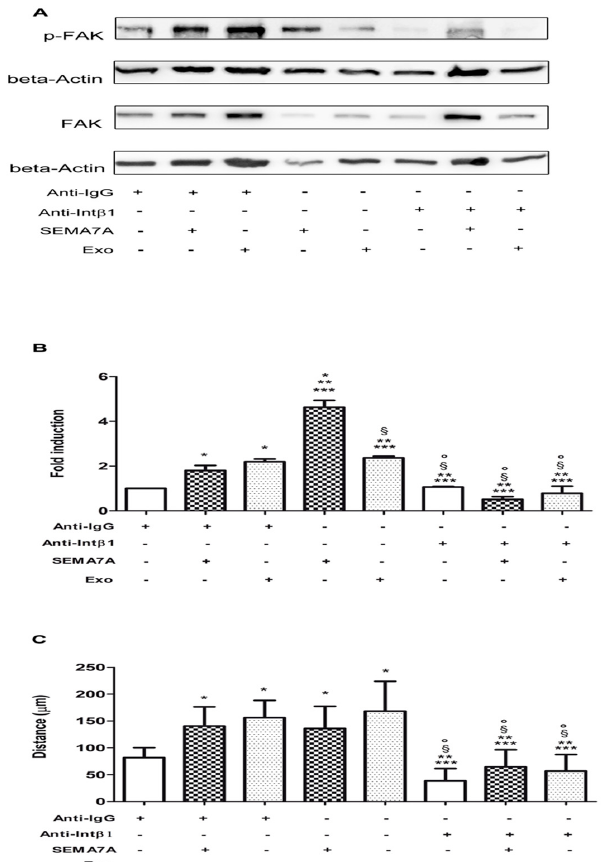
Figure 6. Blocking integrin beta1 on GSC (Glioma Stem Cells) affects the activation of Focal Adhesion Kinase (FAK) signalling and the motility of Glioma Stem Cells (GSC) induced by either Semaphorin7A (SEMA7A) or Glioma Associated Stem Cells (GASC)-derived exosomes. ( A ) Representative Western blotting for FAK and pFAK of GSC treated with anti-Immunoglobulin G (Anti-IgG) antibody, 5 µ g / mL for 65 min, anti-Immunoglobulin G (anti-IgG)antibody, 5 µ g / mL for 60 min and SEMA7A 100 ng / mL for 5 min, anti-IgG antibody 5 µ g / mL for 60 min and GASC-derived exosomes 10 µ g / mL for 5 min, SEMA7A 100 ng / mL for 5 min, GASC-derived exosomes 10 µ g / mL for 5 min, anti-Integrin beta 1 blocking antibody 5 µ g / mL for 65 min, anti-Integrin blocking antibody 5 µ g / mL for 60 min and SEMA7A 100 ng / mL for 5 min and anti-Integrin blocking antibody 5 µ g / mL for 60 min and GASC-derived exosomes 10 µ g / mL for 5 min. ( B ) Densitometric analysis was performed using the software available in the Gel-doc instrument (Alliance Uvitec, Ltd. Cambridge, UK) to quantify the level of FAK phosphorylation. The histogram represents results reported as the Fold Change of p-FAK of different treatments vs. cells treated with the anti-IgG antibody. Values were calculated as the ratio of IOD (Integrated Optical Density) pFAK / FAK after normalisation on beta actin level. ( C ) A motility assay was performed in cells treated as described in B. Histogram represents the distance covered after 8 h, calculated measuring the width of the gap between the two margins of scratched monolayer. Data are presented as means ± standard deviation of 4 replicates. * p < 0.05 vs. Anti-IgG, ** p < 0.05 vs. Anti-IgG + SEMA-7A, *** p < 0.05 vs. Anti-IgG + Exo, § p < 0.05 vs. SEMA-7A, ◦ p < 0.05 vs. Exo. Statistical analysis was performed by repeated measurements one-way ANOVA followed by Bonferroni Multiple Comparison post-test (GraphPad Prism 5, San Diego,